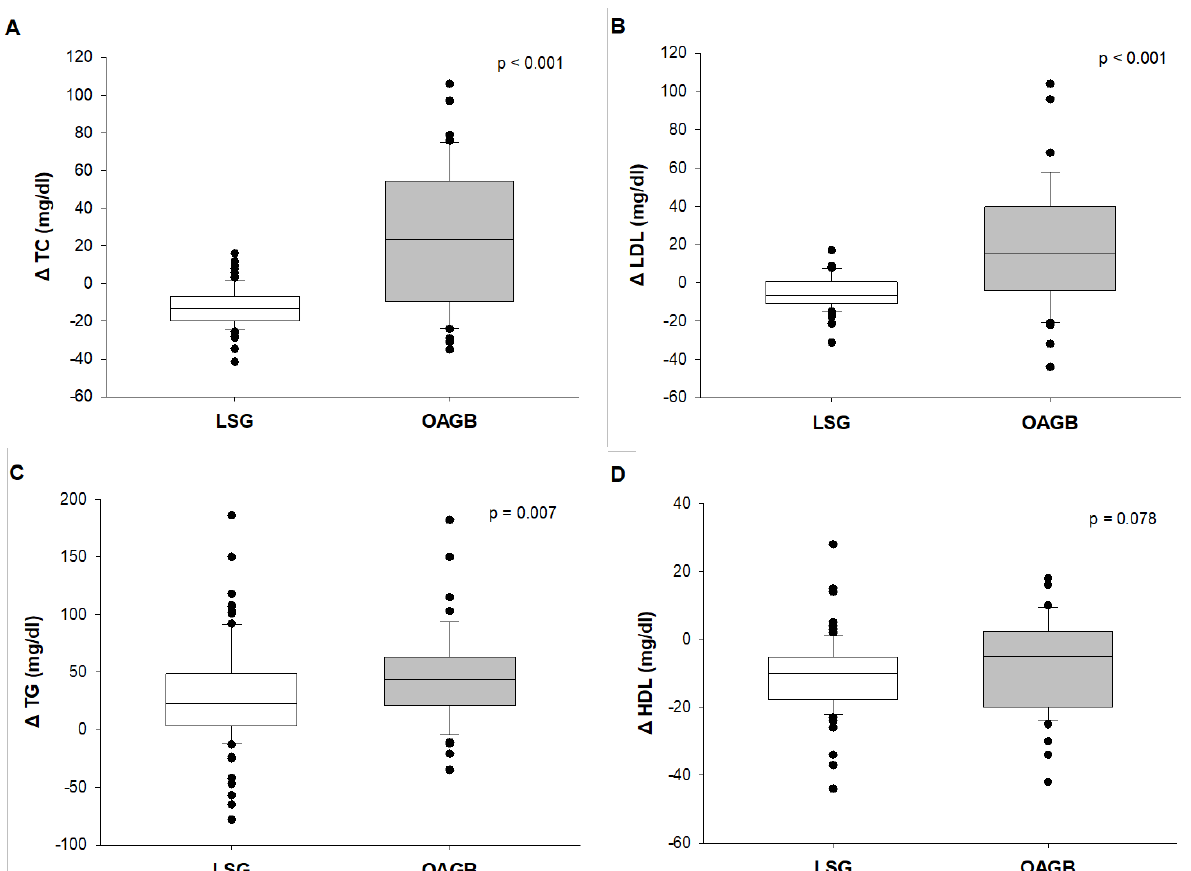
BMI: Body Mass Index, TC: Total Cholesterol, HDL: High Density Lipoprotein -cholesterol, NHDLC: non HDL-choles- terol, LDL: Low Density Lipoprotein-cholesterol, TG: triglycerides, adj: adjustment. Statistical Analysis: Mann-Whitney Rank Sum Test for the comparison between delta; multiple regression model for the adjustment for Δ BMI, sex and age. Significant values are represented in bold.